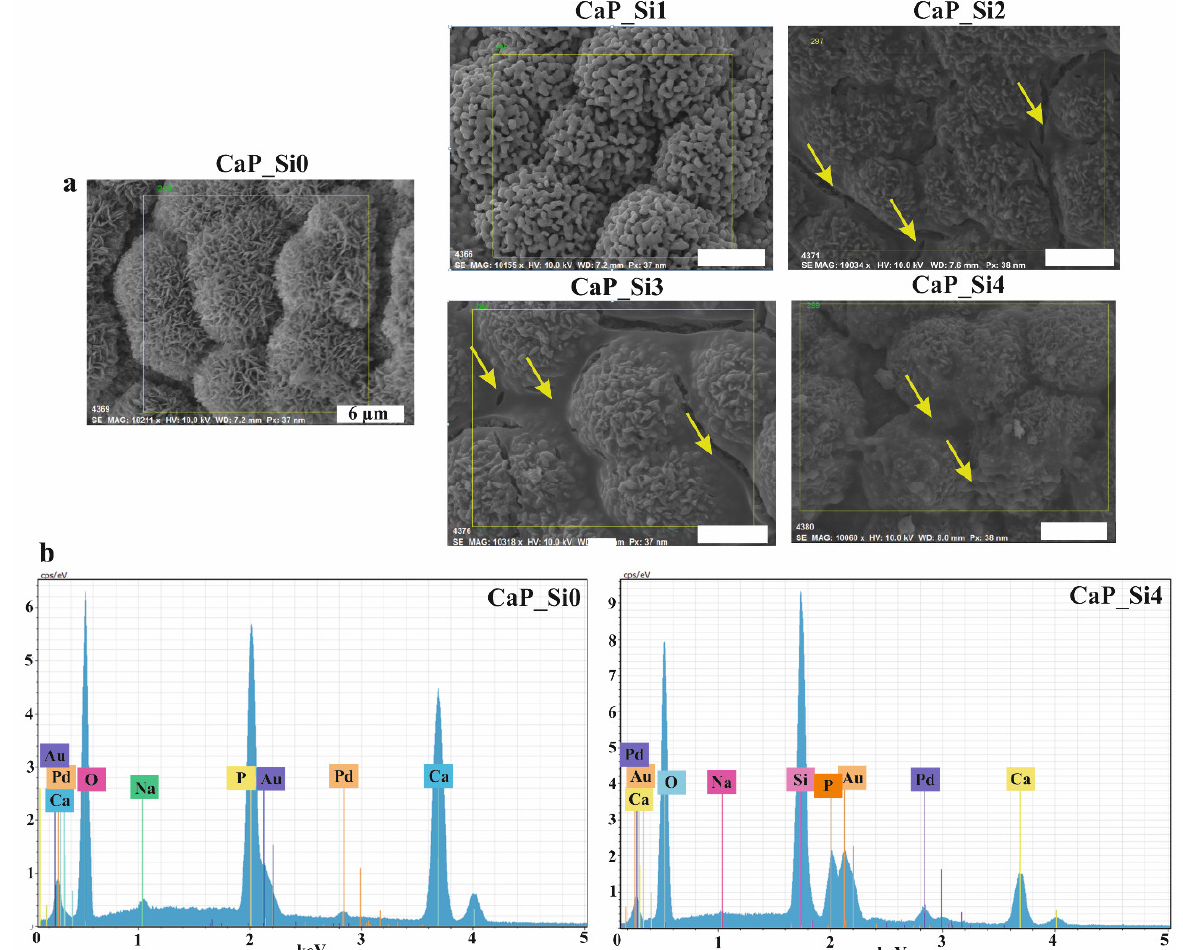
Figure 3. ( a ) SEM micrographs of CaP crystals and ( b ) EDS spectrum of the CaP_Si0 and CaP_Si4 scaffolds. Glassy phase between globules is depicted by yellow arrows. Scale bar: 6 μm.